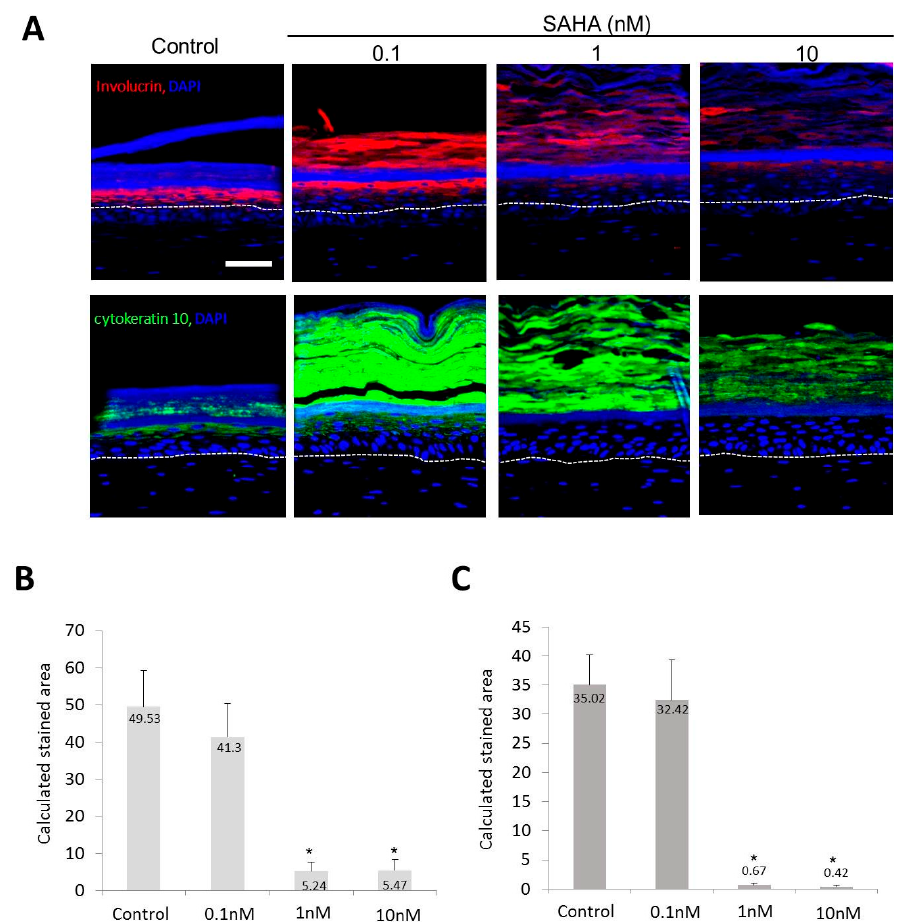
Figure 5. Expression of epidermal differentiation markers in SE. ( A ) Confocal microscopic staining (red; involucrin staining, green; cytokeratin 10 staining, ×200, scale bar is 50 μ m); ( B ) Calculated stained area for involucrin after SAHA treatment; ( C ) Calculated stained area for cytokeratin 10 after SAHA treatment. Sis circular areas were selected and the average area stained above a certain intensity was determined. Statistical significance was calculated with the Mann-Whitney- U test, * p < 0.01 compared with the control. This experiment was repeated twice and representative areas are shown.